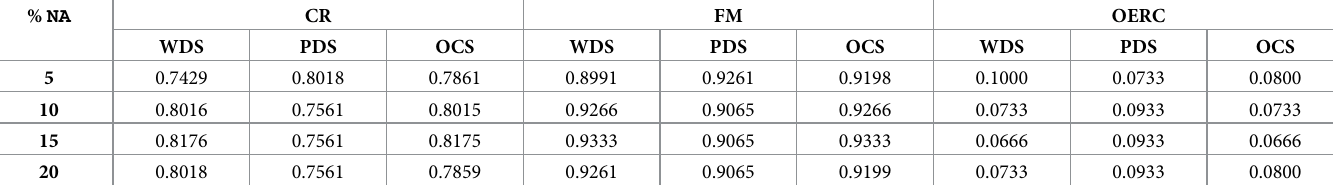
Table 1. Performance of the VKFCM-K-LP clustering algorithm with the WDS, PDS and OCS strategies for the dataset Iris Plant .